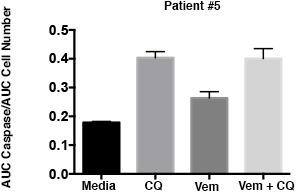
Caspase 3/7 activation occurs in the presence of BRAF and autophagy inhibition in cells with inherent BRAFi resistance.Patient #5 primary cells were treated with BRAFi (Vem 1 μM), autophagy inhibition (CQ 10 μM) or a combination of the two drugs. Cell growth and caspase 3/7 activation was monitored every four hours using Incucyte monitoring for 72 hr. The area under the curve (AUC) for caspase 3/7 activation was normalized to the AUC of cell numbers over time. mean ± s.e.m., n = 3).